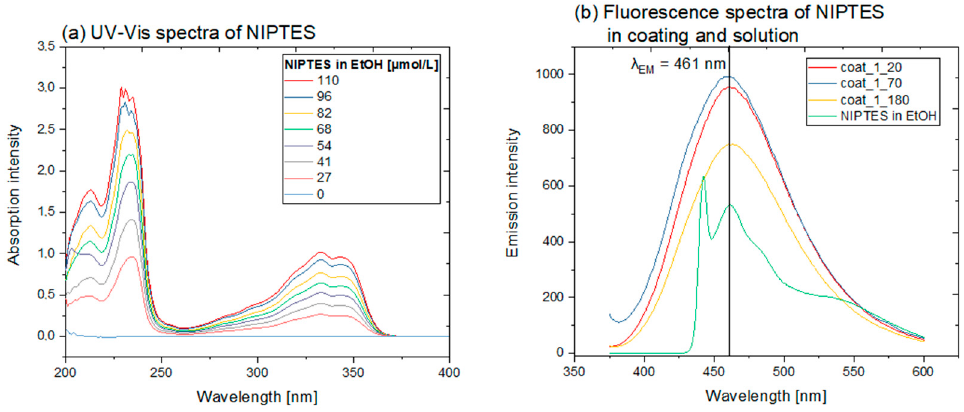
Figure 7. ( a ) UV-Vis absorption spectra of NIPTES dissolved in ethanol at various concentrations and ( b ) fluorescence spectra of coat_1 samples containing NIPTES in the organosilane coating and of NIPTES in ethanol solution (excitation wavelength λ = 365 nm).